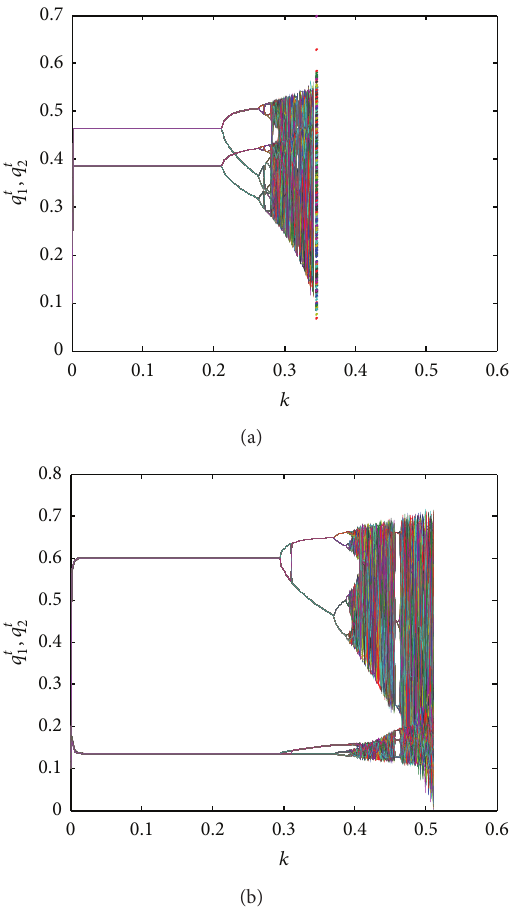
Figure 1: Bifurcation and chaos of the map (6) at the parameters: (a) = 0.3 , 𝜀 = 0.7 , and 𝛾 = 0.7254 ; (b) 𝑎 = 3 , 𝑎 = 3 , 𝑏 = 1.5 , 𝑐 = 0.3 , 𝜀 1 2 = 0.3 , 𝜀 = 0.7 , and 𝛾 = 2.7694 . 𝑏 = 1.5 , 𝑐 = 0.3 , 𝜀 1 2